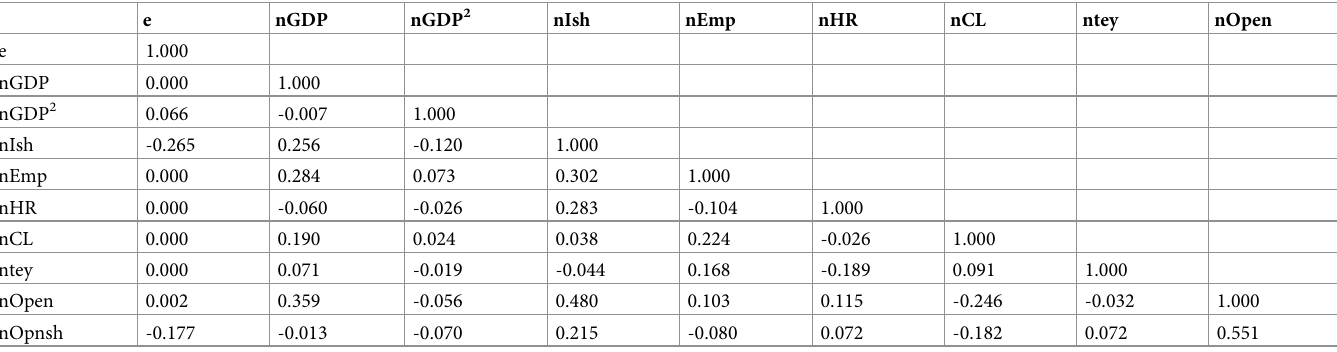
Table 4. Bilateral correlation among selected new